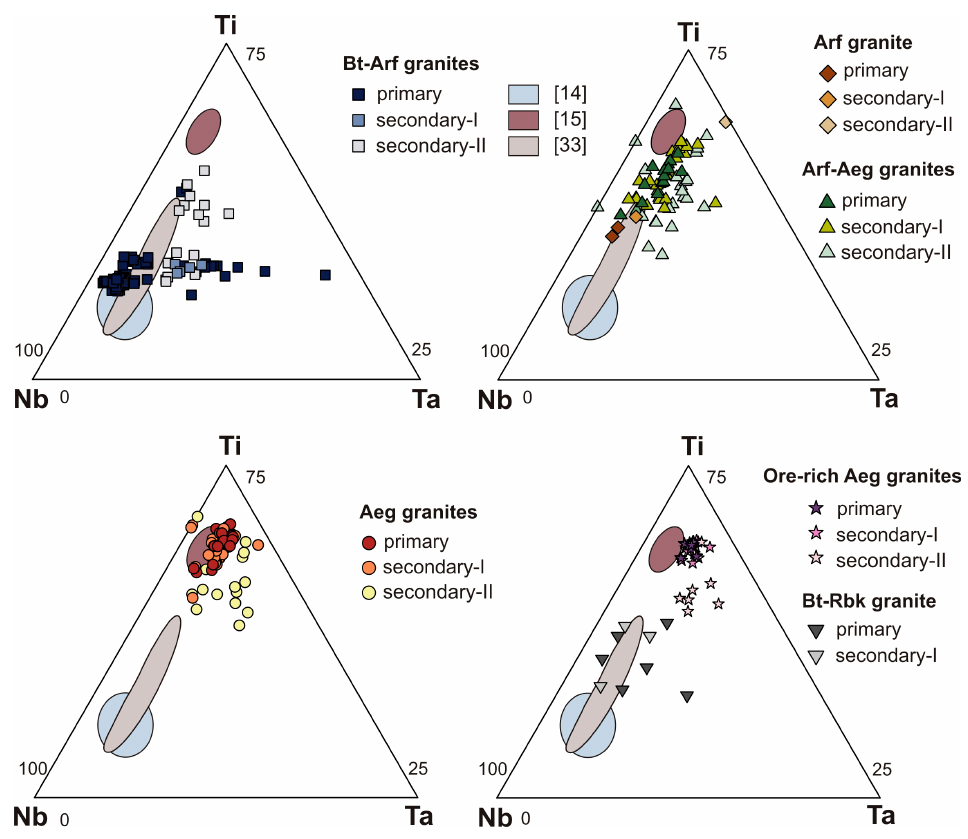
Figure 3. Ternary classification diagrams (B-site) for pyrochlore-group minerals from the Katugin granites. [14], [15], [33] = fields of fluornatropyrochlores from literature [14,15,33],